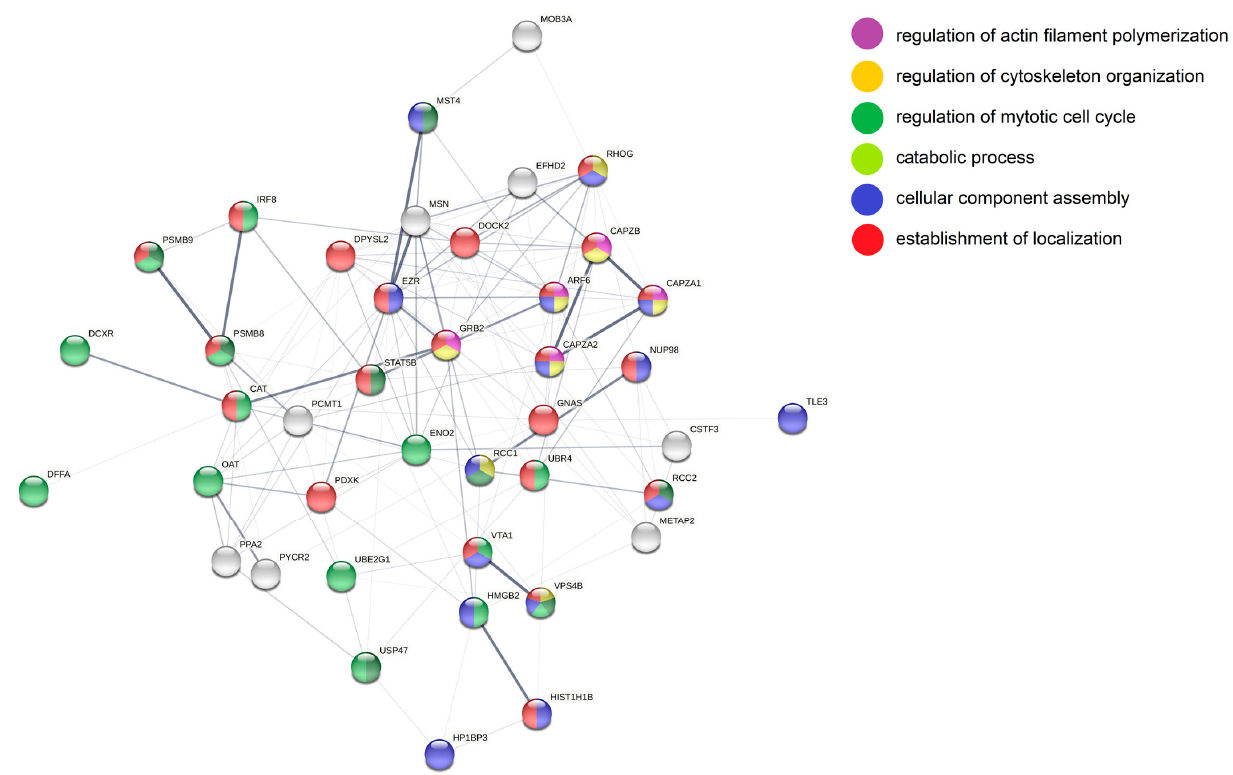
Figure 9. STRING analysis of proteins less abundant in both knockout cell lines. Nodes represent individual proteins and are colored based on the annotations placed at the right side of the figure. Line strength specifies confidence level from lowest (0.150) to highest (0.900).